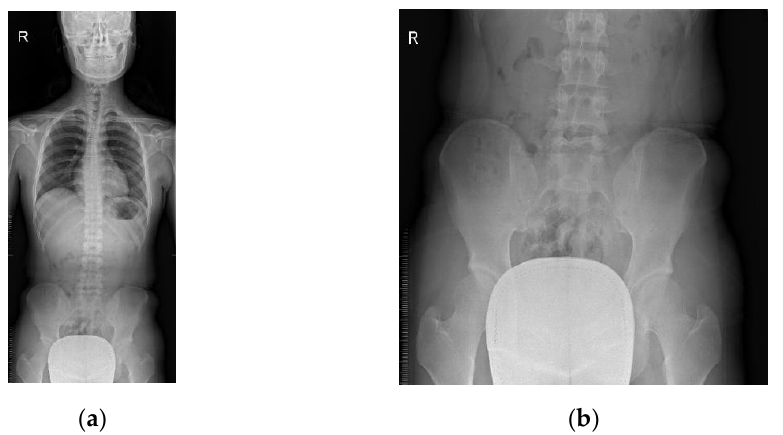
Figure 3. Radiographic changes with malalignment: ( a ) whole-spine AP radiograph and ( b ) pelvic portion radiograph.